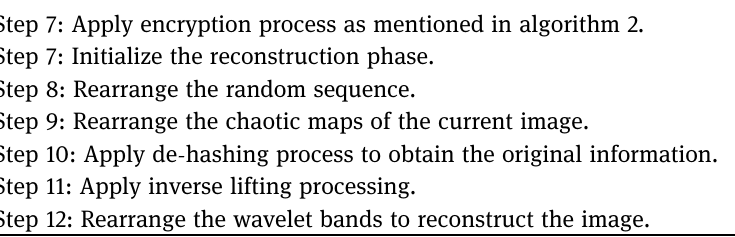
Algorithm 2. Image